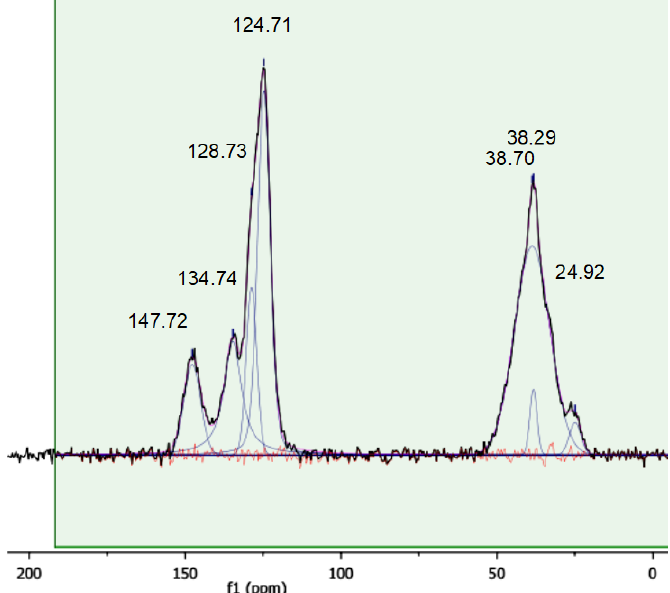
Figure 5. 1 H- 13 C CP MAS spectrum of Gel_H 2 SO 4 . Contact time 1 ms, MAS rate 10 kHz, T = 25 °C.